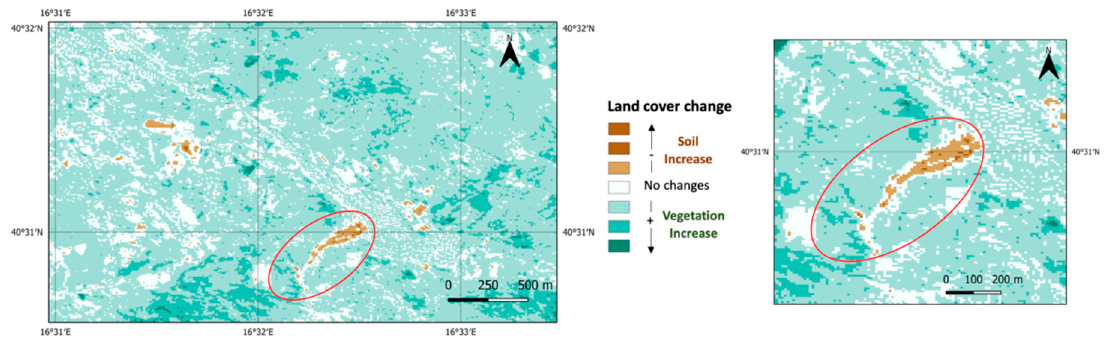
Figure 4. Map of NDVI difference between February 2019 and February 2018. The area affected by the landslide is in the red ellipse.